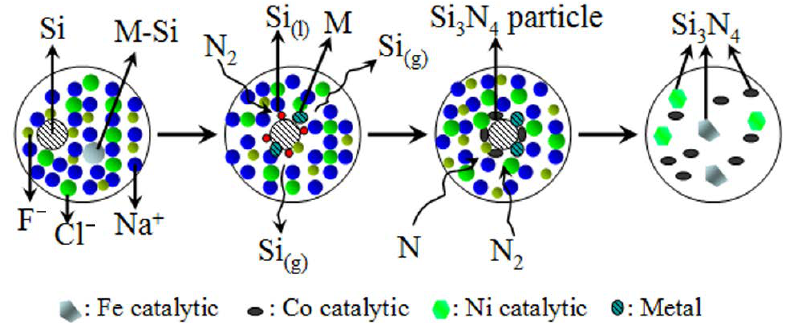
Figure 7. Suggested mechanism for the catalytic nitridation of Si powder.